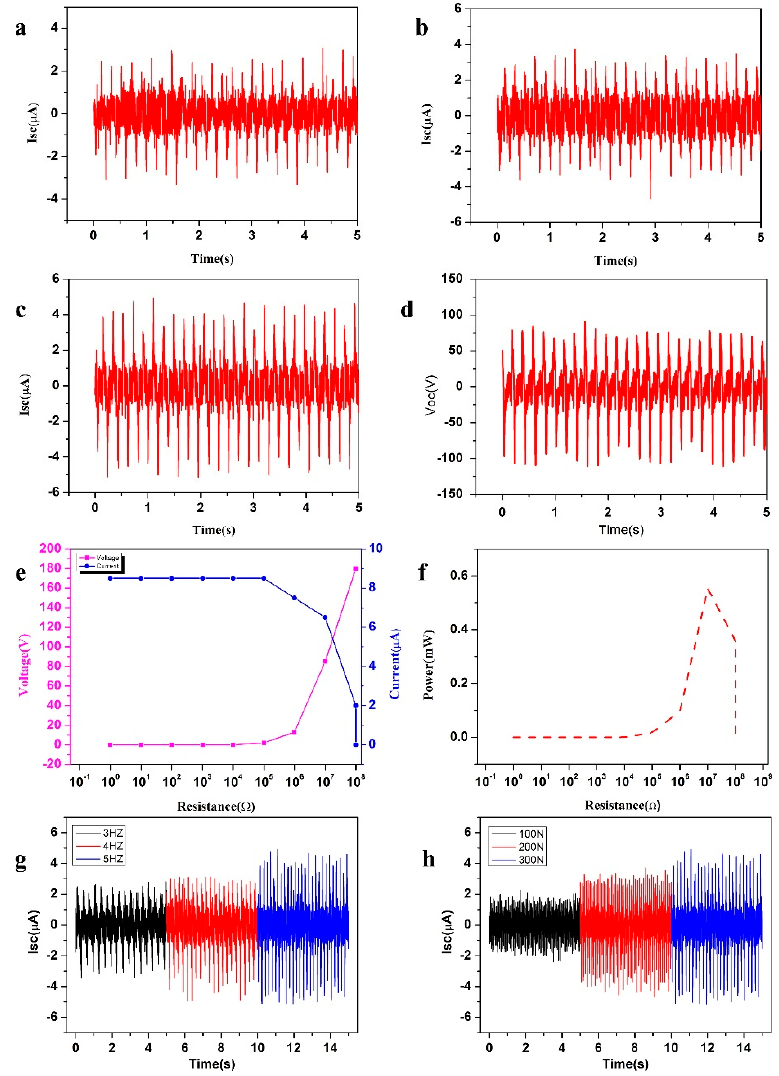
Figure 3. Output performance of the SNTN. ( a ) Short-circuit current of the inner triboelectric unit; ( b ) Short-circuit current of the outer triboelectric unit; ( c ) Short-circuit current of the SNTN; ( d ) Open-circuit voltage of the SNTN; ( e ) Dependence of the voltage and current of the SNTN on the external load resistance; ( f ) Dependence of the power of the SNTN on the external load resistance; ( g ) Short-circuit current of the SNTN with di ff erent frequencies; ( h ) Short-circuit current of the SNTN with di ff erent forces.